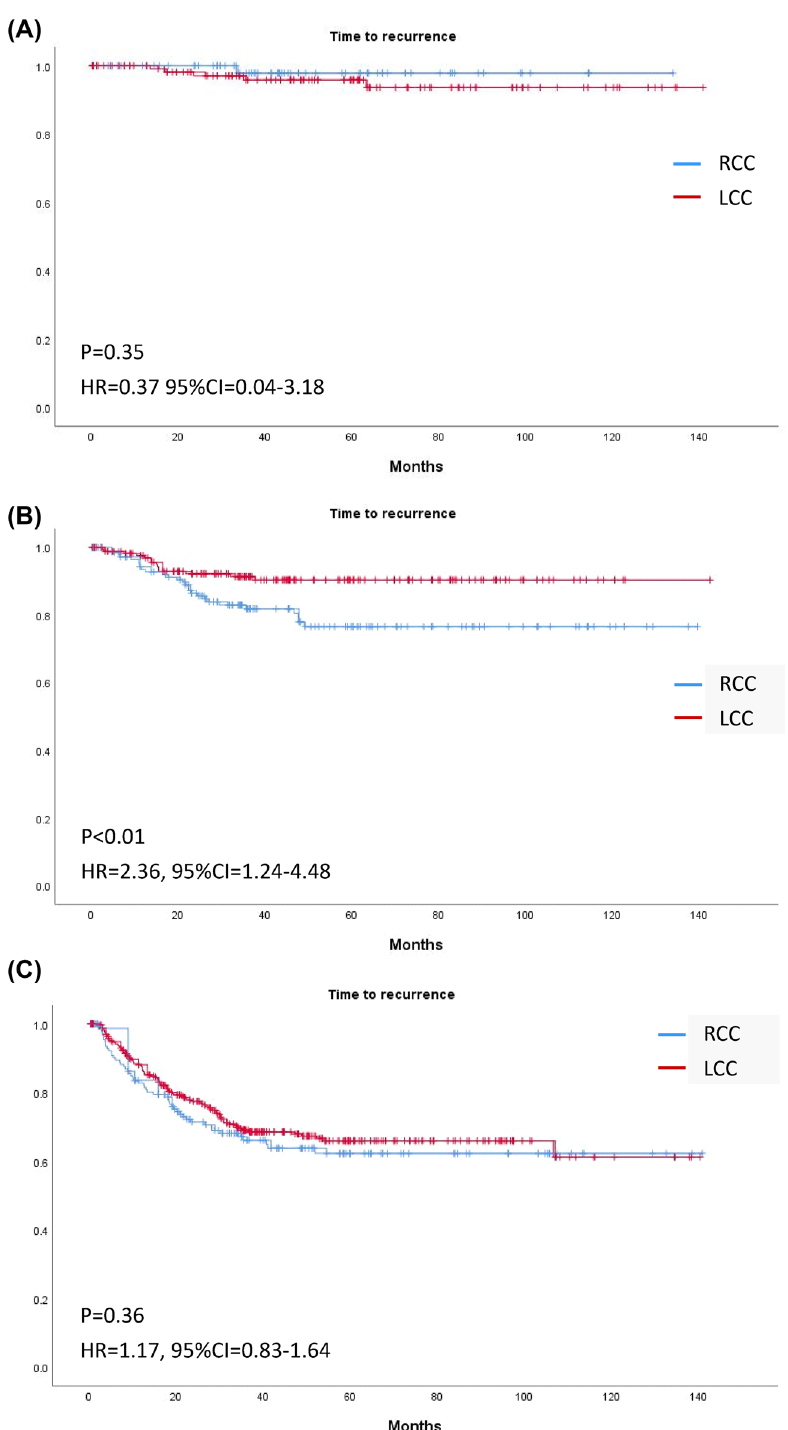
Figure 4. Kaplan–Meier curves of time to recurrence of right-sided and left-sided colon cancer in ( A ) Stage I, ( B ) Stage II, and ( C ) Stage